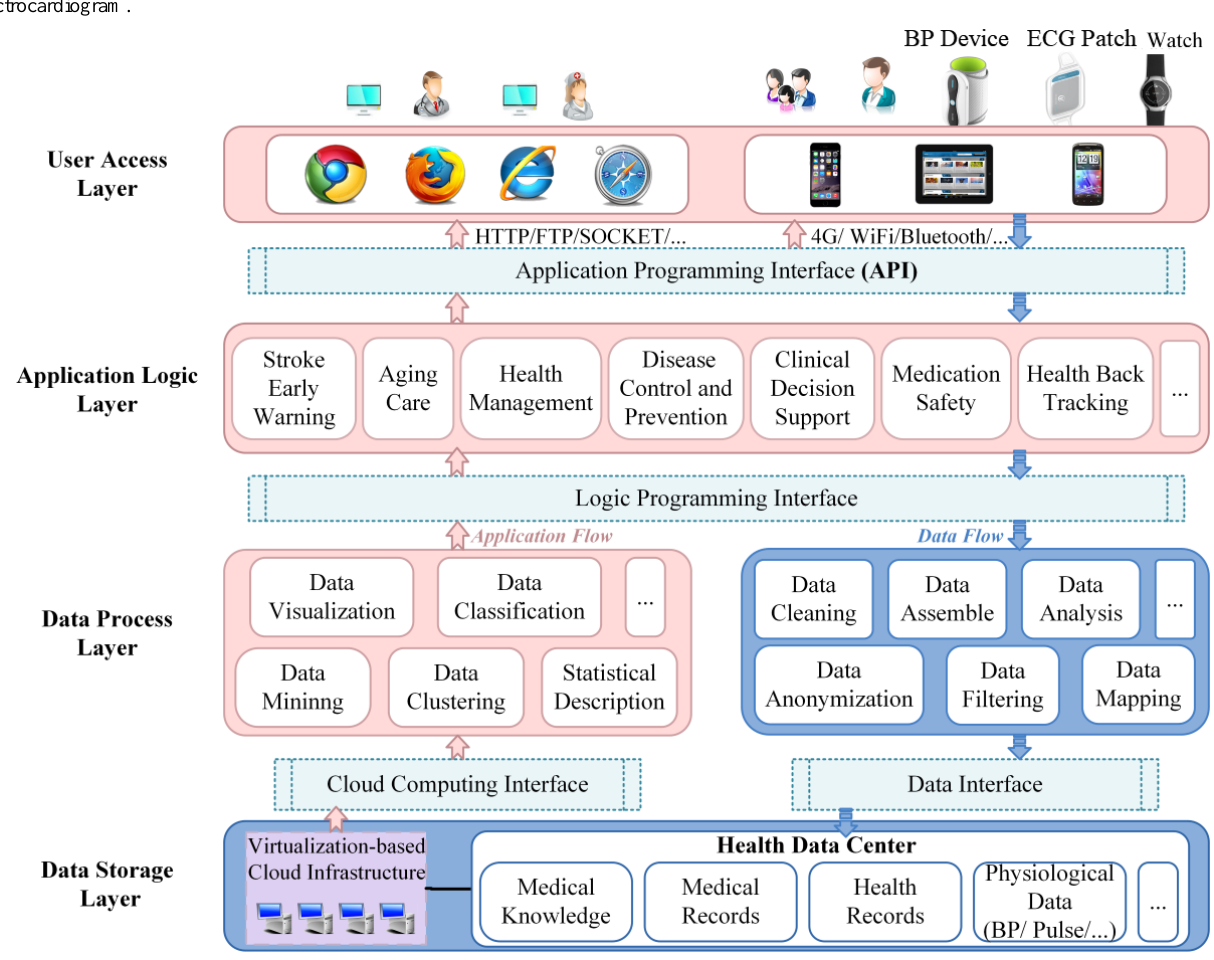
algorithm, and at the data center, an abnormal BP data analysis algorithm for real-time early stroke warning using users’ terminal